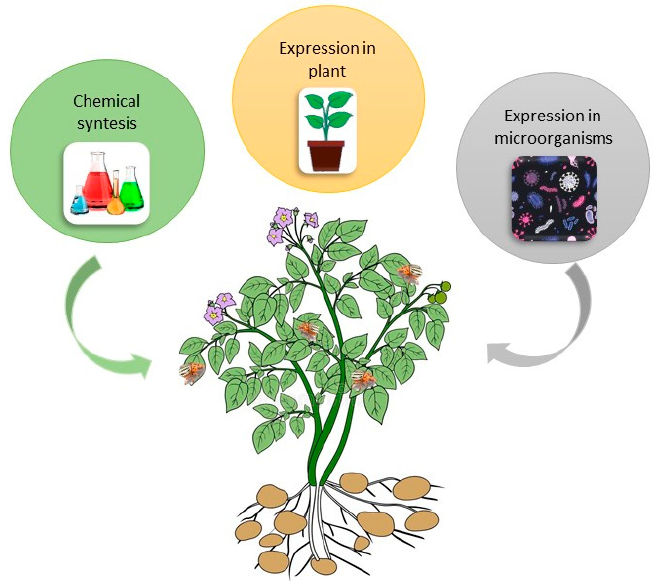
Figure 4. Possible methods for producing double stranded RNA (dsRNA) for pest control.